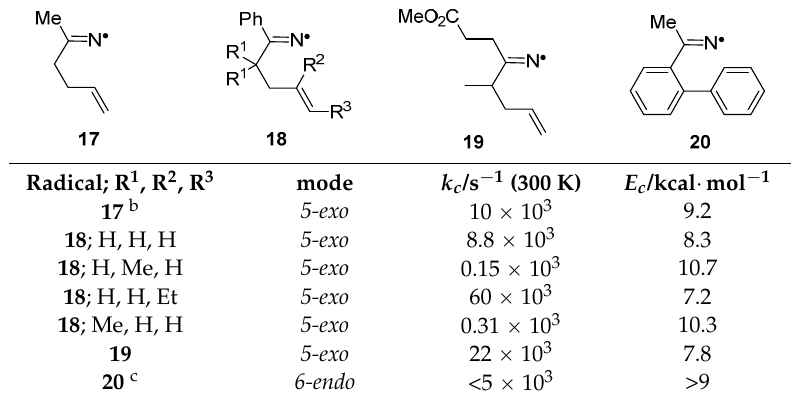
Table 2. Rate parameters for cyclisations of unsaturated iminyl radicals in solution a .